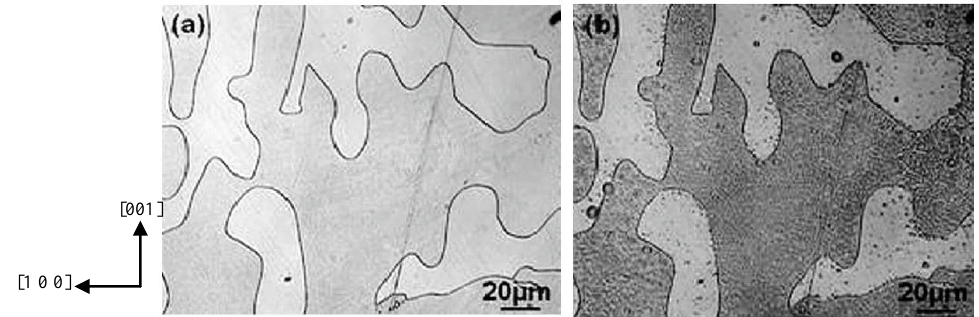
Figure 6. Domain structure in lithium niobate observed under optical microscope after